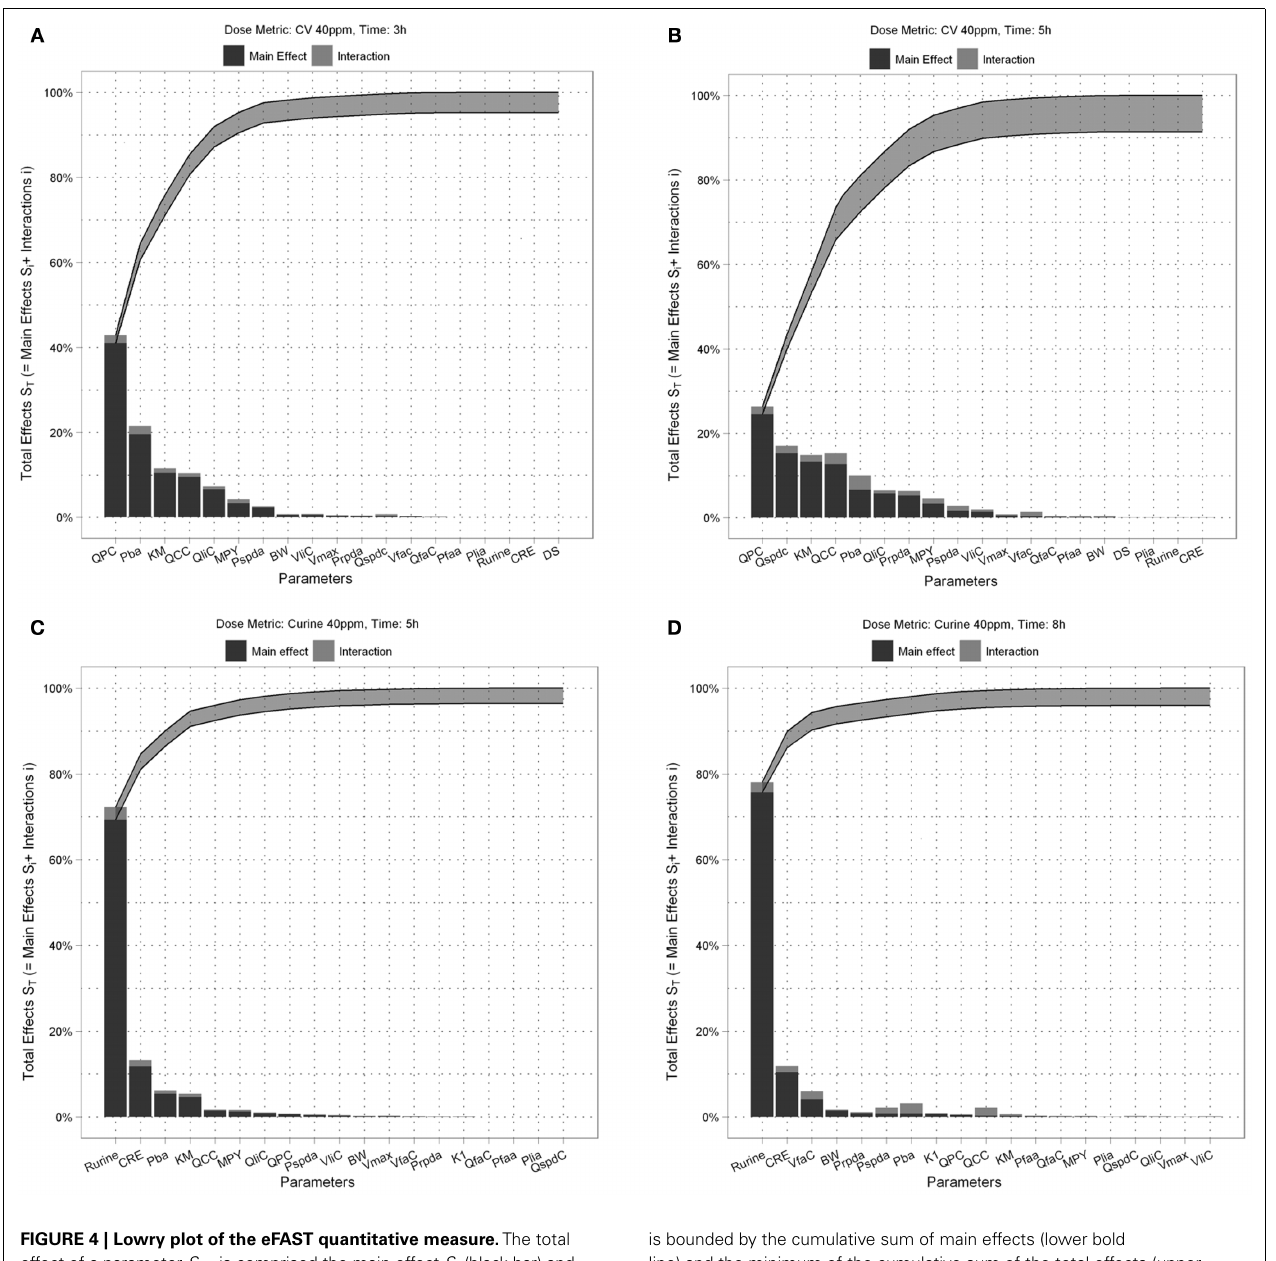
is bounded by the cumulative sum of main effects (lower bold line) and the minimum of the cumulative sum of the total effects (upper bold line), (A) CV at 3h, (B) CV at 5h, (C) C urine at 5h and (D) C urine at